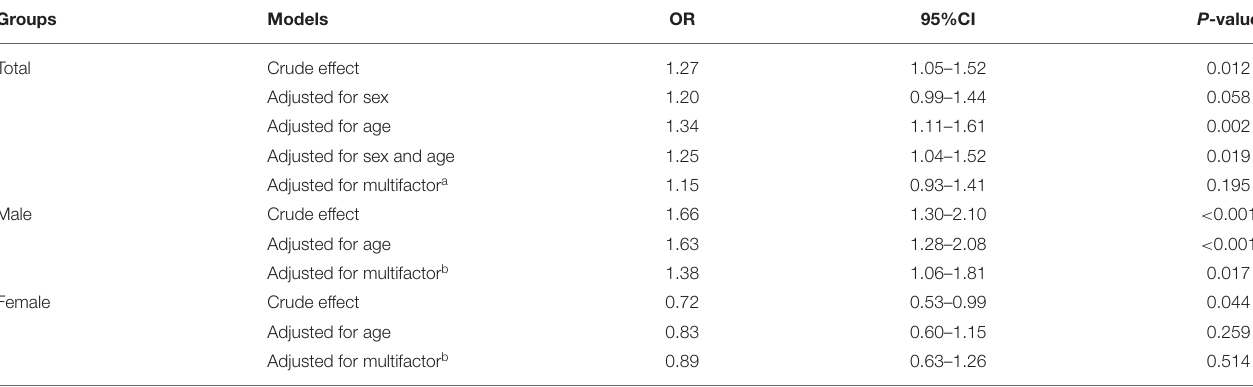
TABLE 2 | Association between eating away from home and risk of high serum uric acid. Groups Models OR